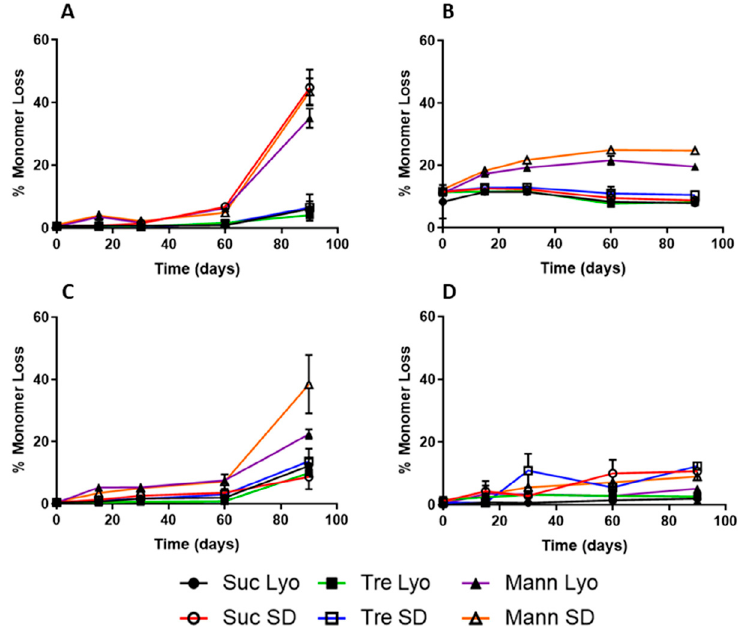
Figure 16. SEC studies on stability of samples containing myoglobin ( A ), BSA (bovine serum al- bumine) ( B ), β -lactoglobulin ( C ), or lysozyme ( D ). Formulations are lyophilized (Lyo) or spray-dried (SD) and have three sugar excipients (sucrose—Suc, trehalose—Tre, mannitol—Mann). Reproduced with permission from [175], Elsevier, 2019.